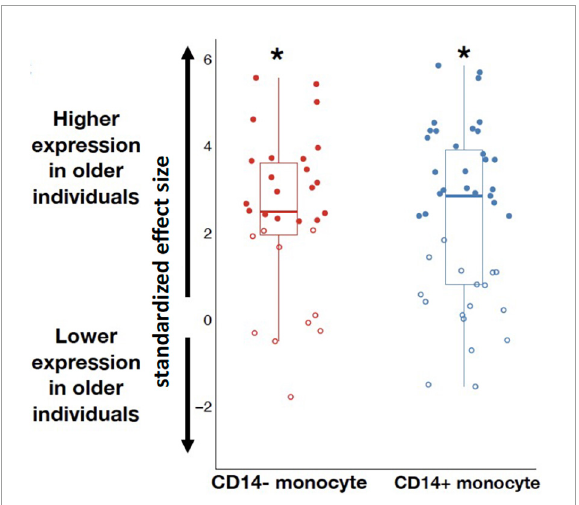
FIGURE2 Correlation between z-transformed values of (log) urinary neopterin and suPAR (ng/mg creatinine) measured within the same urine samples. The thick black line represents the overall correlation. Each colored point represents a single urine sample from which both neopterin and suPAR were measured. Colored lines represent individual random slopes (i.e., an individual’s rate of change in neopterin following an increase in suPAR within that individual).